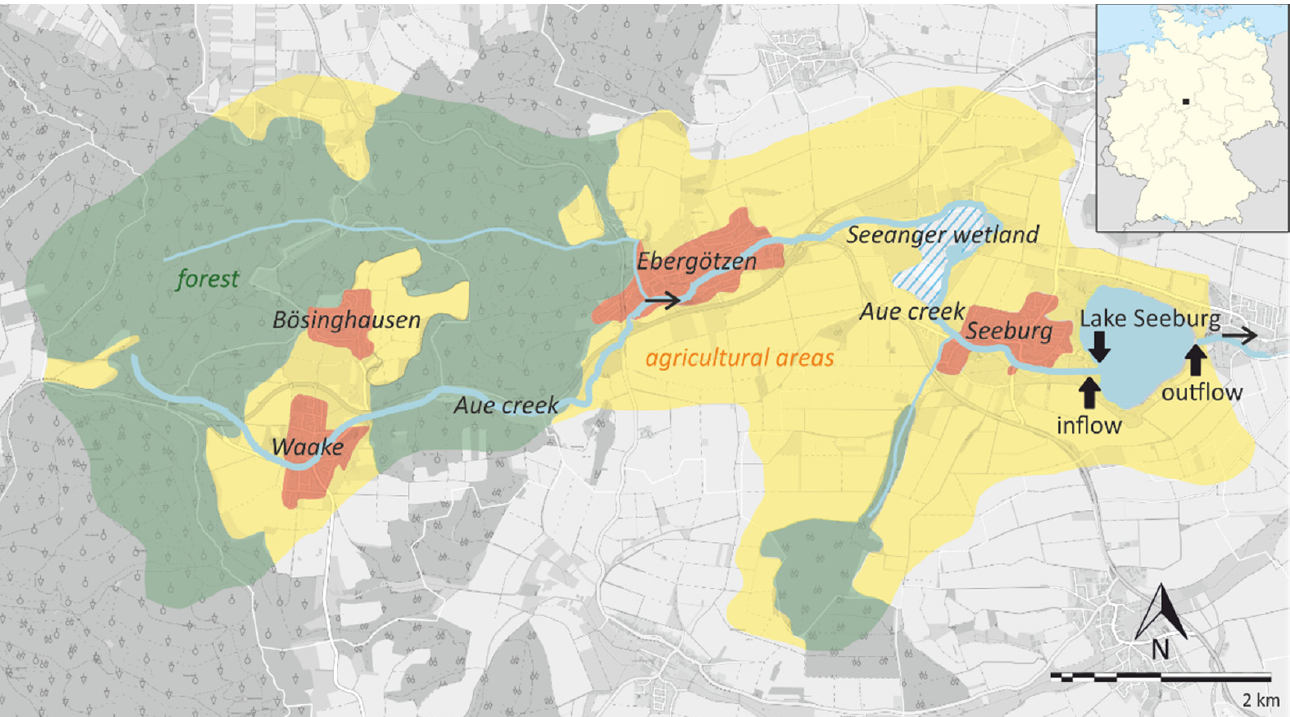
Figure 1. Map of Lake Seeburg showing the catchment area and the sampling locations (arrows) at the main inflow (Aue creek), the western part of the lake (bathing pier), and the eastern part near the outflow. The shaded area represents the Seeanger wetland upstream of the main tributary (Aue creek). Simplified after NLWKN [24]. For an enlarged map of the sampling points, see Figure S1. To assess the nutrient dynamics of the lake, especially for N and P, we conducted a long-term monitoring campaign. Water sampling and analyses were carried out monthly at the main inflow (Aue creek), in the western part of the lake (pier), and in the eastern part near the main outflow over a period of 36 months between January 2017 and December 2019. Sediment sampling for pore water analysis was performed simultaneously with water sampling in the western part of the lake in 2018. The sampling locations are shown in Figure